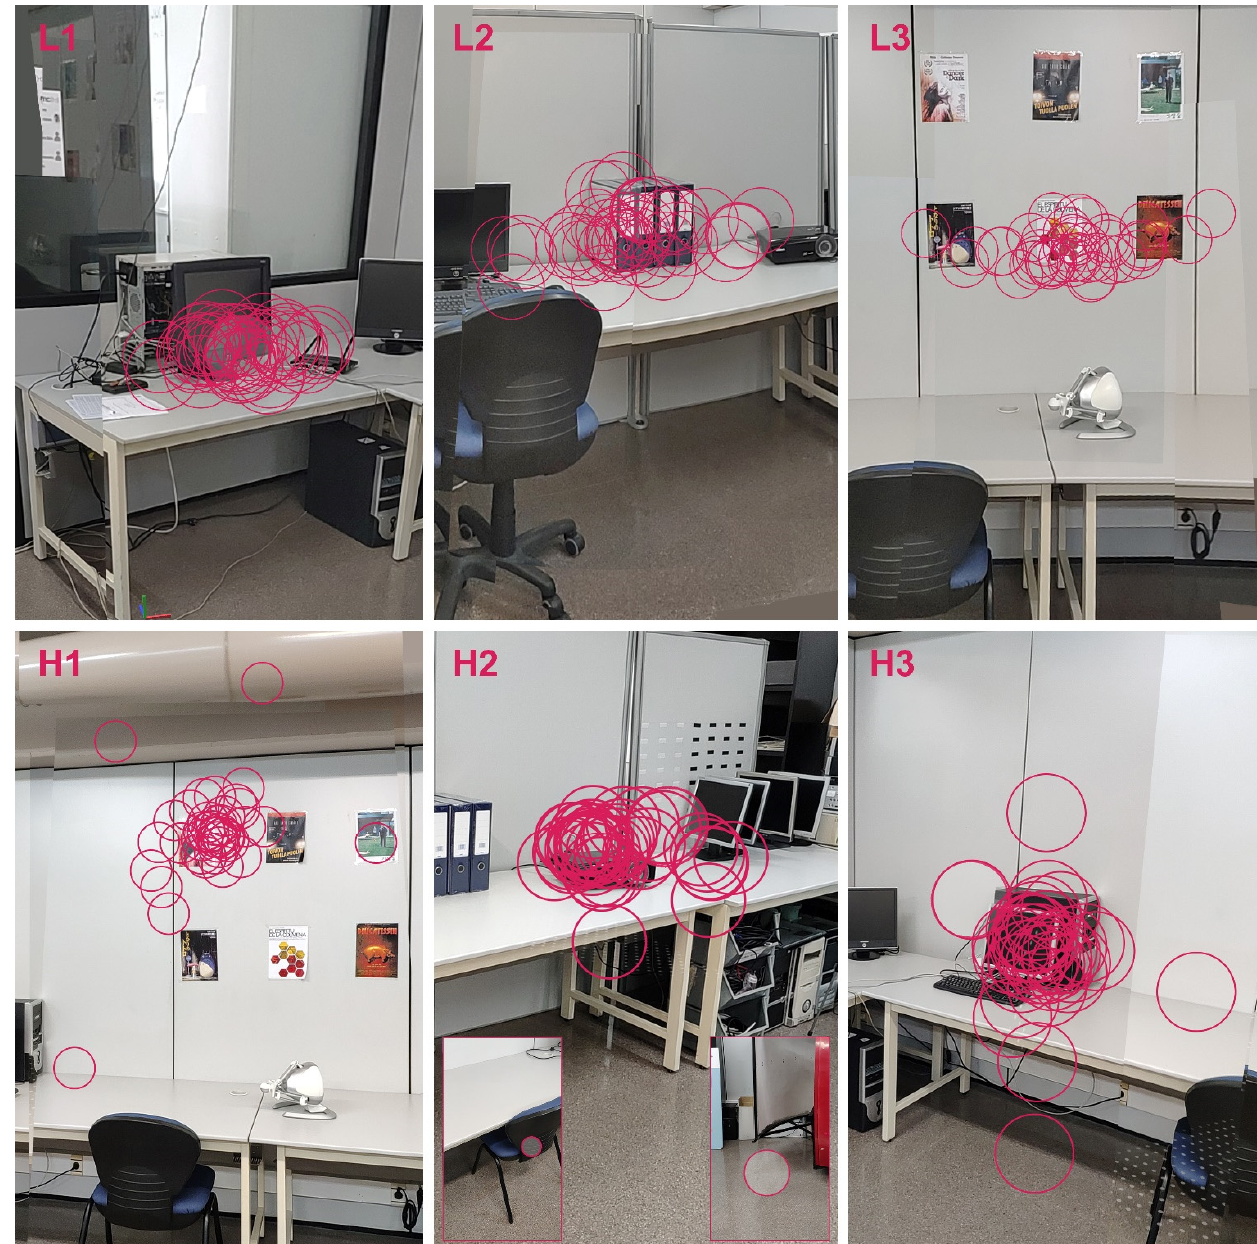
Figure 9. Overlay of the AR annotations found by the 40 study participants.